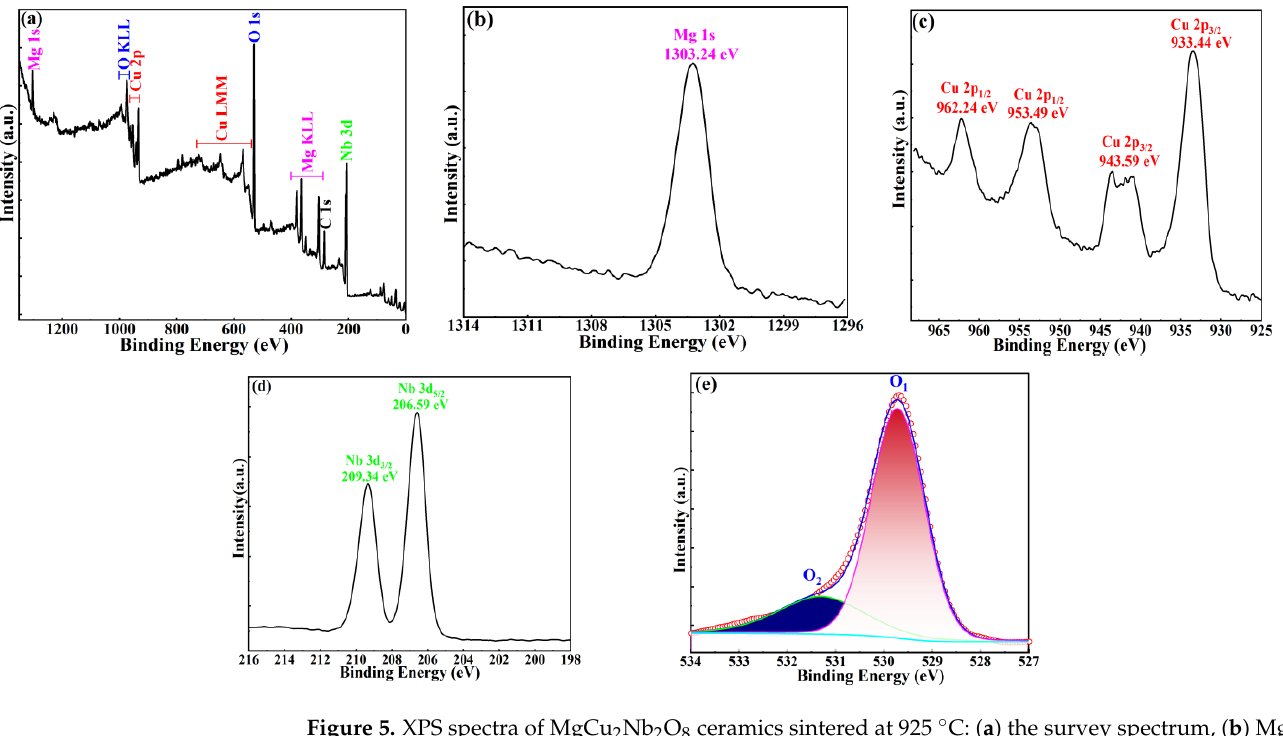
Figure 4. ( a ) The Raman spectra of MgCu 2 Nb 2 O 8 ceramics; ( b ) The correlations between Q × f values and FWHM values.